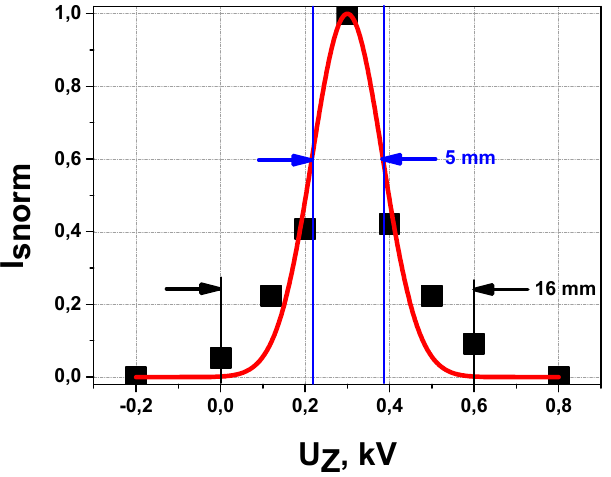
Figure 14. Secondary Xe ++ beam profile on “stop” detector in ISTTOK HIBD experiments with time-of-flight measurements of plasma potential.